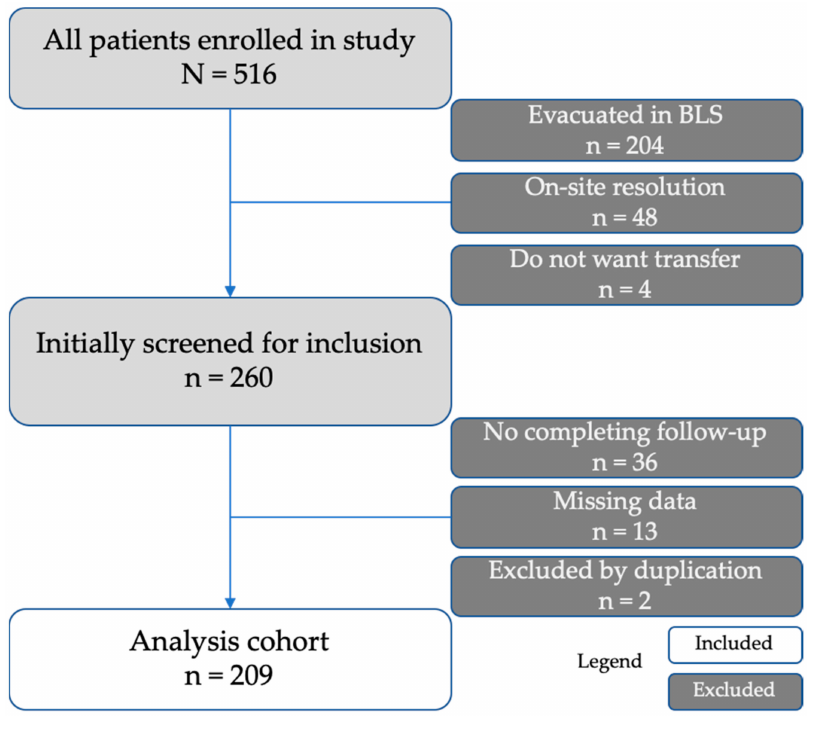
Figure 1. Study participants flowchart. BLS: basic life support Table 1. Demographic variables (reference rates to intensive care unit